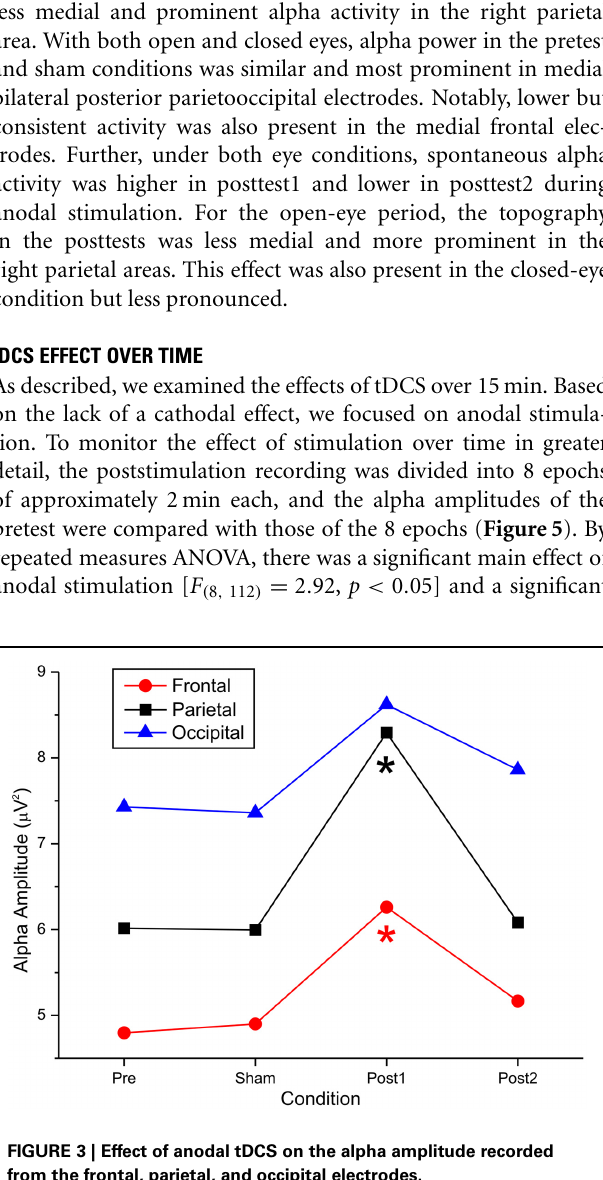
FIGURE 3 | Effect of anodal tDCS on the alpha amplitude recorded from the frontal, parietal, and occipital electrodes.